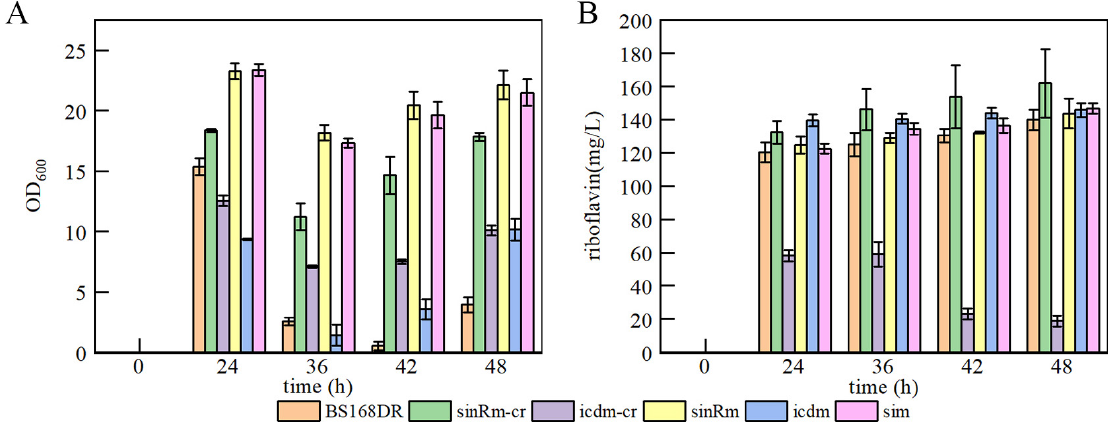
Figure 5. Batch fermentation by strains BS168DR and engineering strains in 500 mL shake flasks containing 80 mL of YP medium. ( A ) time course profile of cell growth; ( B ) riboflavin production during fermentation. The CR fragment was inserted into the middle of the target gene in sinRm-CR and icdm-CR strains, which were seen as the insertion knockout strains for fermentation to study the effect of the knockout mutation on the